Question: Judging by this figure, is the value going up or going down?
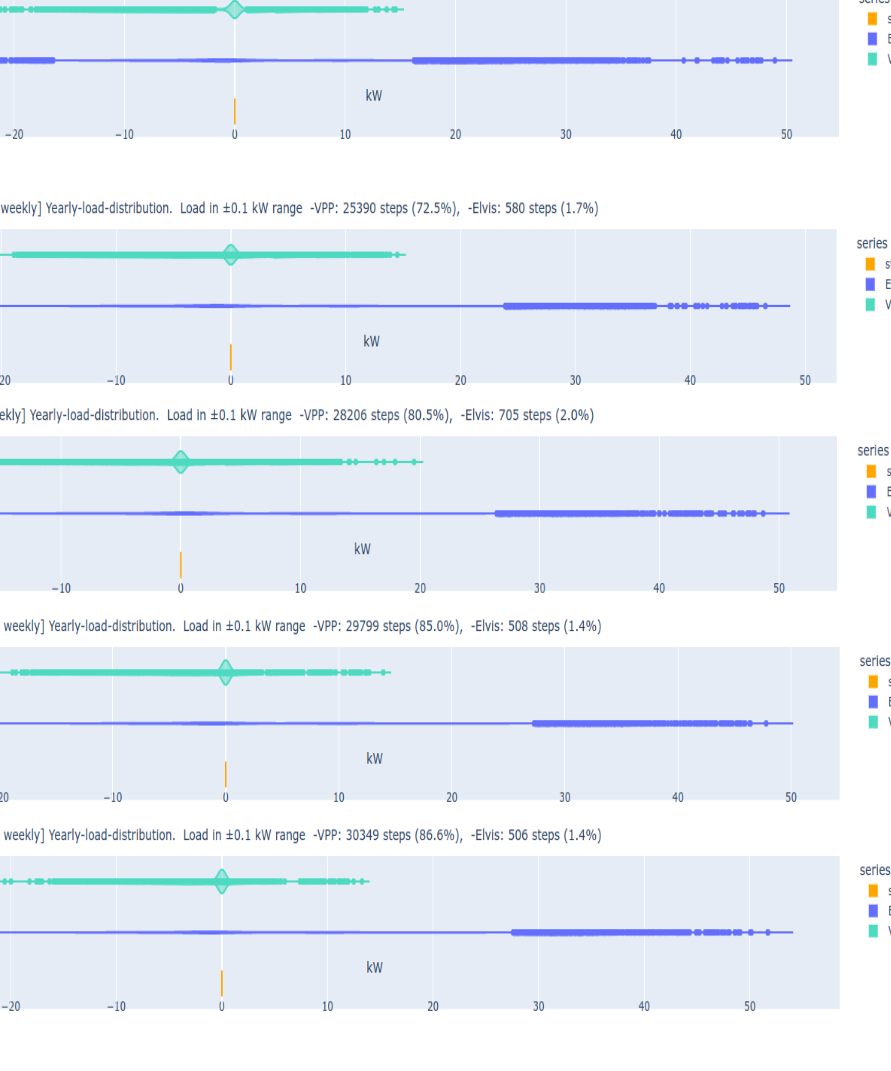
Answer: increasing